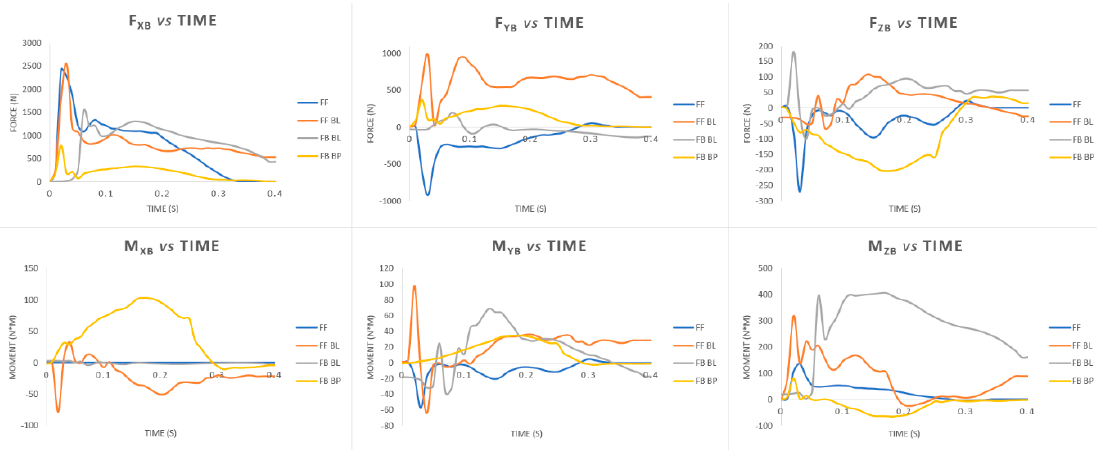
Table 3. Peak values of the equivalent stress (MPa) calculated for di ff erent fall scenarios: Fall Forward (FF), Fall Forward with Balance Loss (FF BL), Fall Backwards with Balance Loss (FB BL), Fall Backwards “By Push” (FB